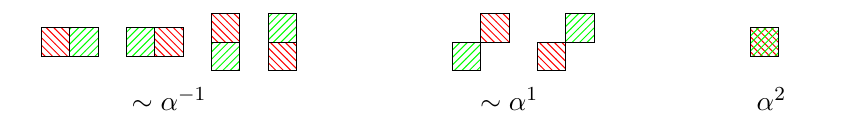
Figure 8 . Example of a family and its dual family with the associated to each member exponent of ( a − ¯ a ) and ( a − ˆ¯ a ) correspondingly.